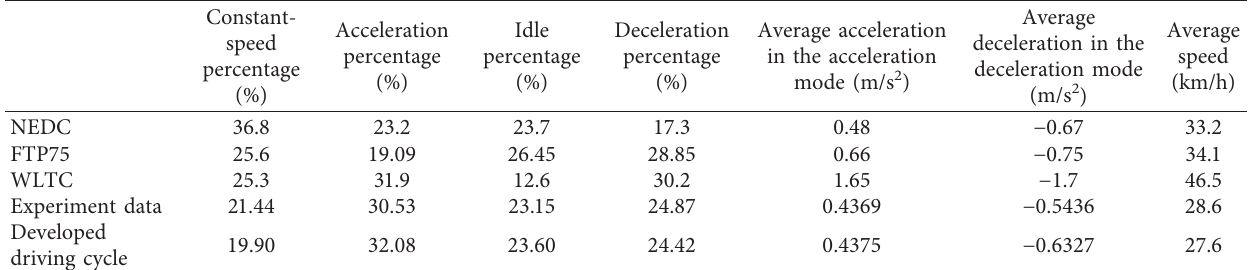
Table 11: Comparison with three typical driving